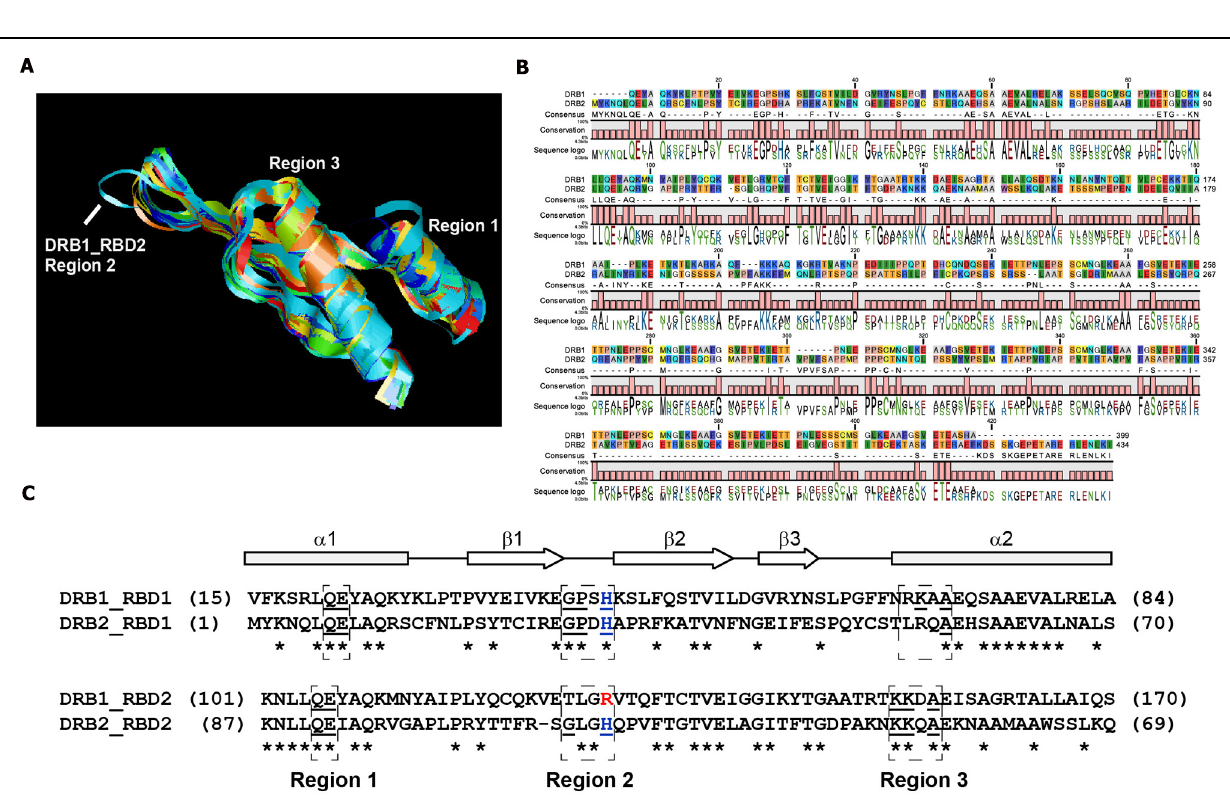
FIGURE 6 | dsRNA binding domains of Arabidopsis DRB proteins. (A) Alignment of dsRBD structures of DRB1 (3ADG and 3ADJ) and predicted structure of DRB2, DRB3, DRB4, and DRB5 RBDs. Region 2 of non-canonical DRB1 dsRBD2 is shown (blue ribbon). (B) Amino acid sequence alignment of Arabidopsis DRB1 and DRB2. (C) Alignment of dsRNA binding domains of DRB1 and DRB2. Secondary folding structure is shown (top). dsRBD regions 1, 2, and 3 are boxed, and their conserved amino acids are underlined. The conserved histidine (H) of region 2 is shown in blue, and arginine (R) in